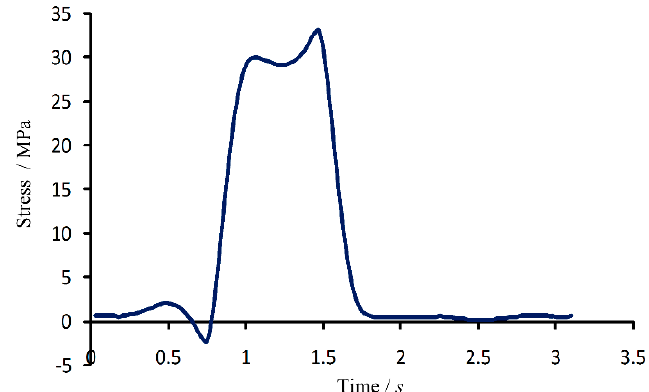
Figure 10. The stress-time curve of concerned point.